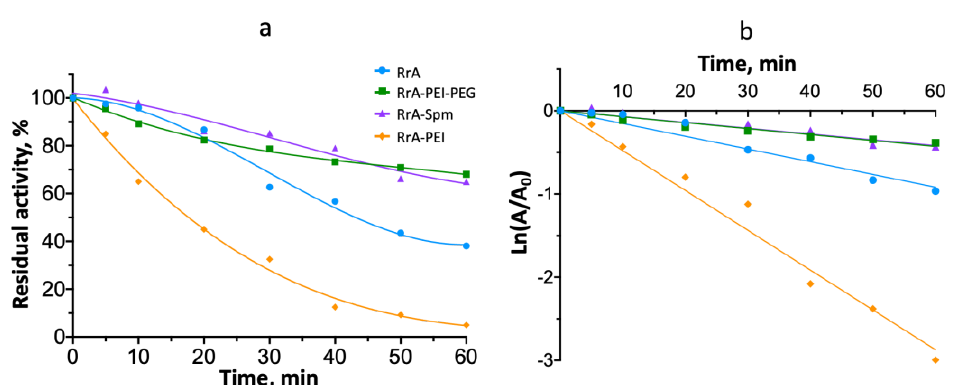
Figure 7. ( a ) Thermal inactivation curves of the residual activity of native RrA and its conjugates after incubation at 53 ◦ C for 60 min; ( b ) semilogarithmic time dependencies. The concentration of the enzyme for all samples was 1 mg/mL. A is the specific activity of the enzyme at time t, and A 0 is at t = 0.